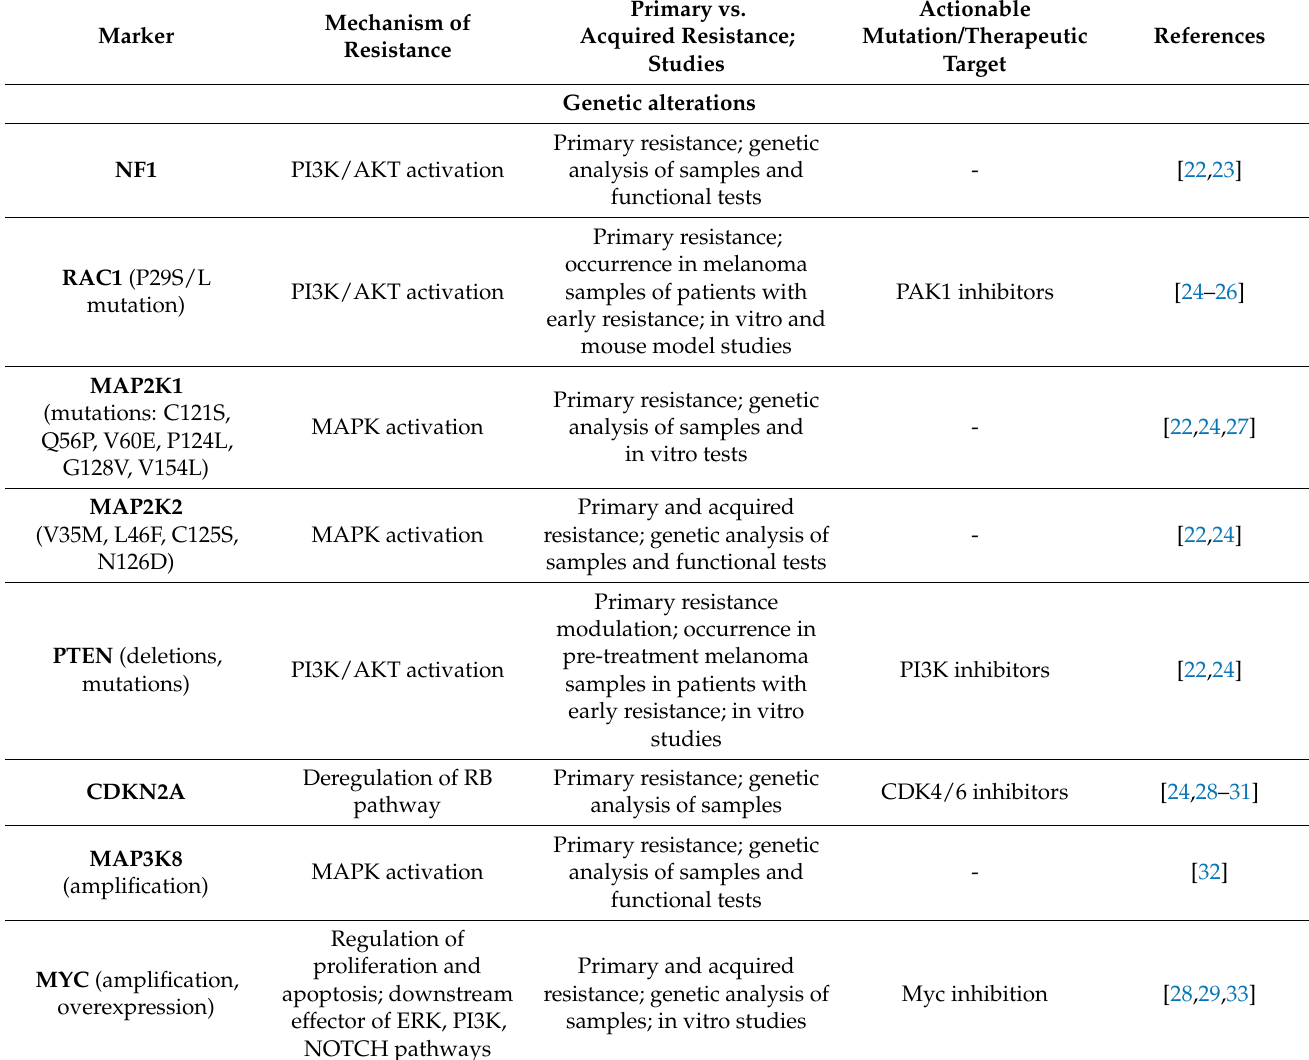
Table 1. The most important genetic and non-genetic factors that are involved in melanoma resistance to targeted therapy. The most promising, potential predictive markers are in